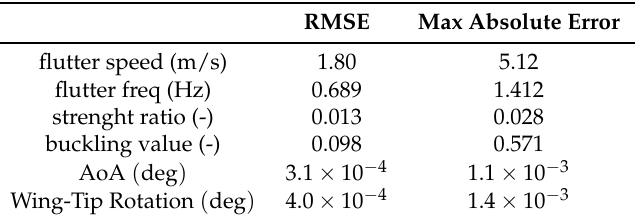
Table 2. Validation set RMSE and max error results.